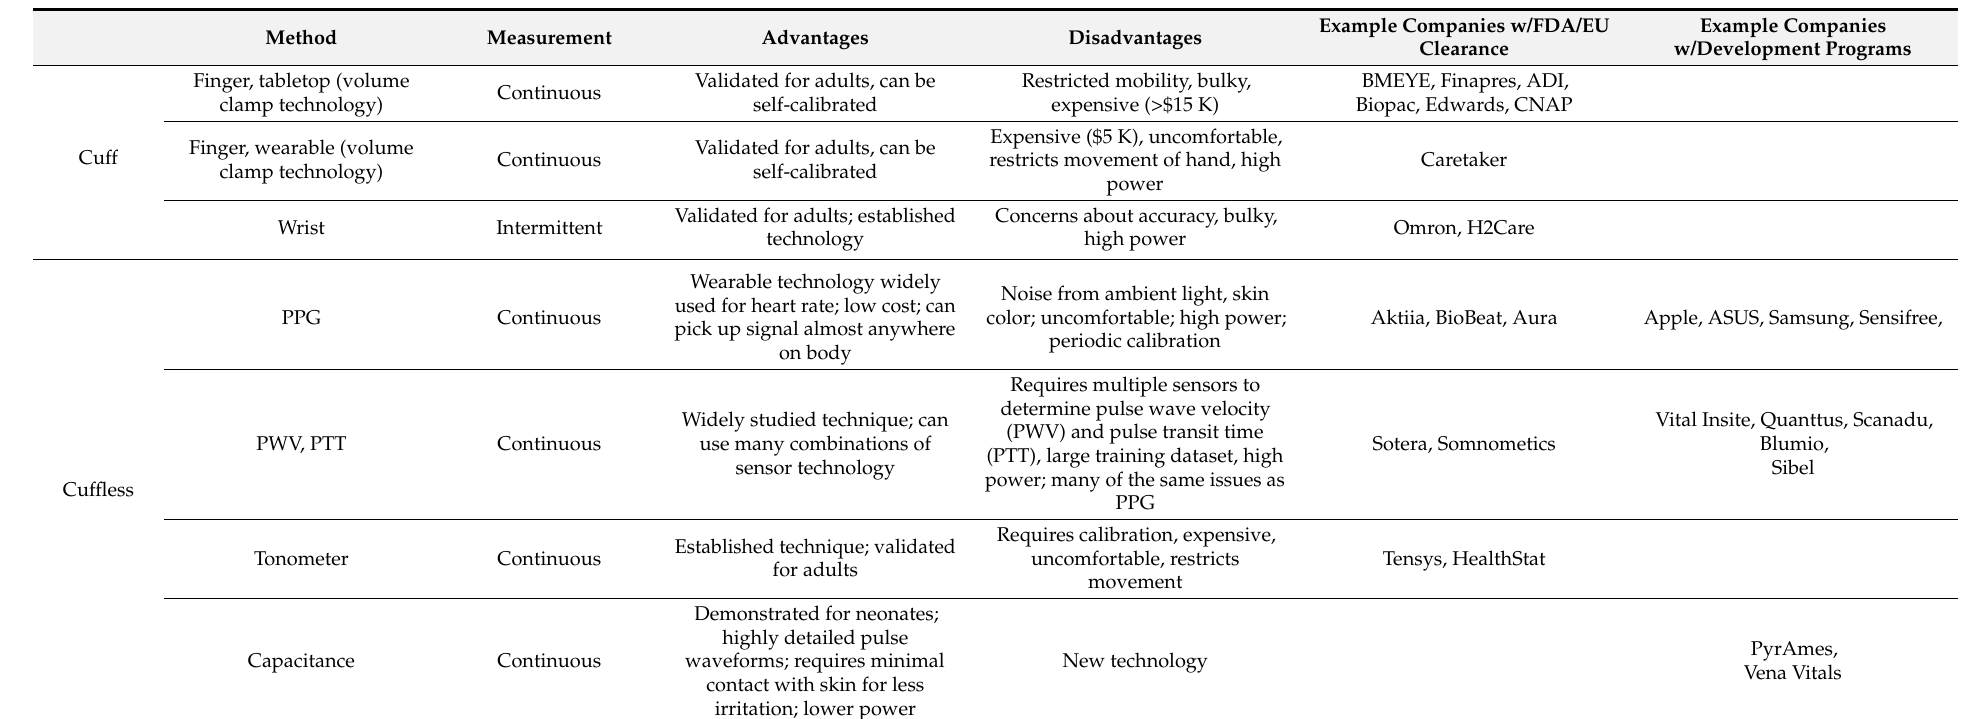
Table 1. Comparison of non-invasive blood pressure monitoring